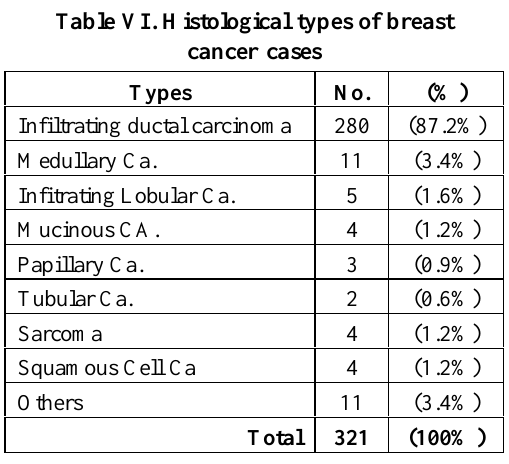
Table VI. Histological types of